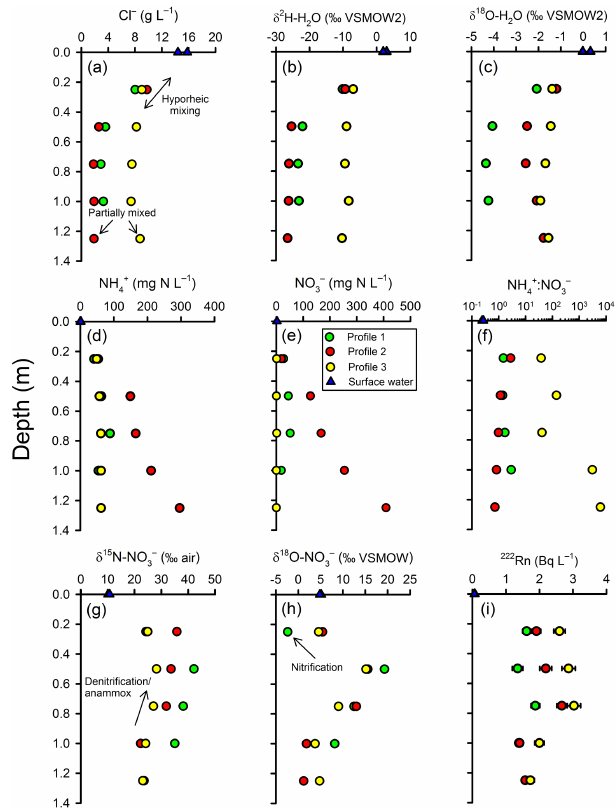
Figure 4. Intertidal zone porewater profiles for selected parame- ters. Based on the trends in chloride (a) and the stable isotopes of water (b–c) , two scales of groundwater–surface-water mixing were apparent in the profiles. In the top 50cm of the profiles, a gradual change in concentration between a surface water and deeper pore- water endmember is consistent with hyporheic mixing. Below the hyporheic zone, chloride concentrations were relatively constant but were intermediate between terrestrial groundwater and surface wa- ter, suggesting return flow from tide-induced circulation. See text for explanations about the other